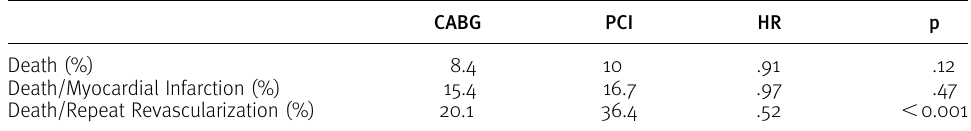
Table 1. 5-YEAR EVENT RATE (Reference 3)